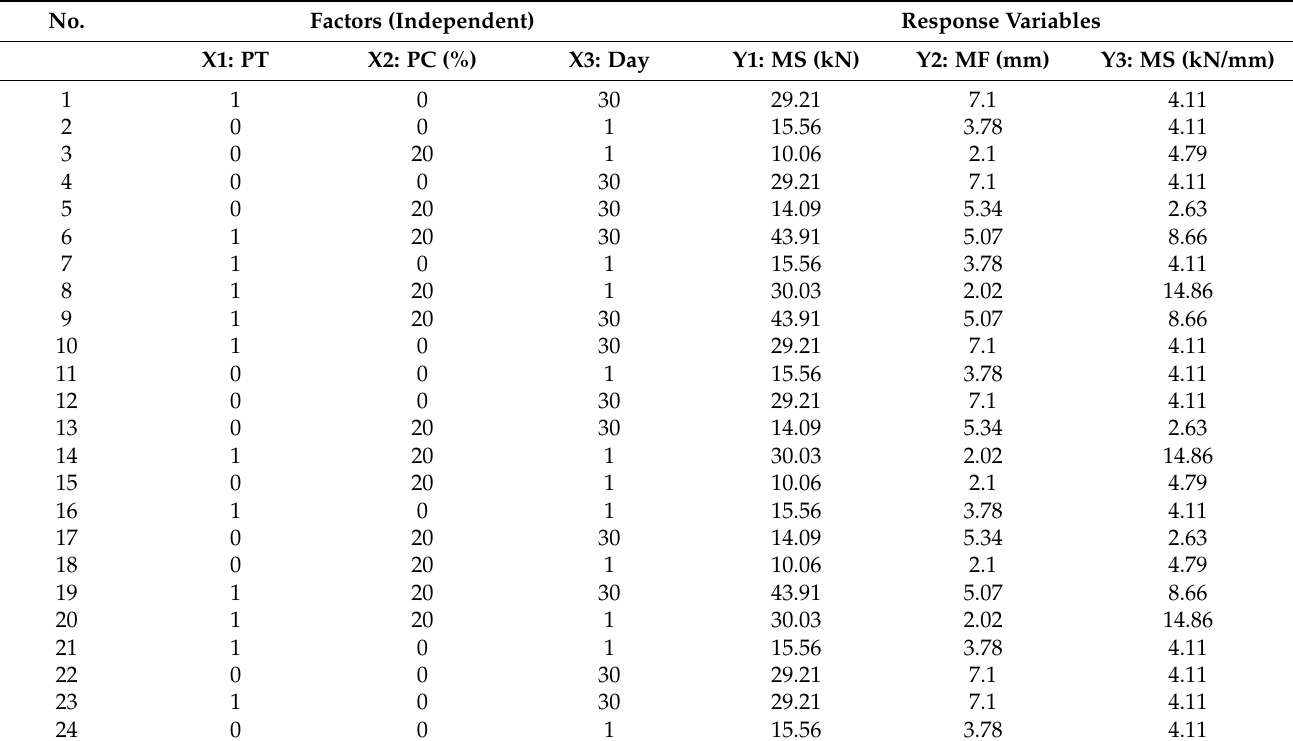
Table 3. Experimental design of polymer-modified asphalt mixtures using RSM.